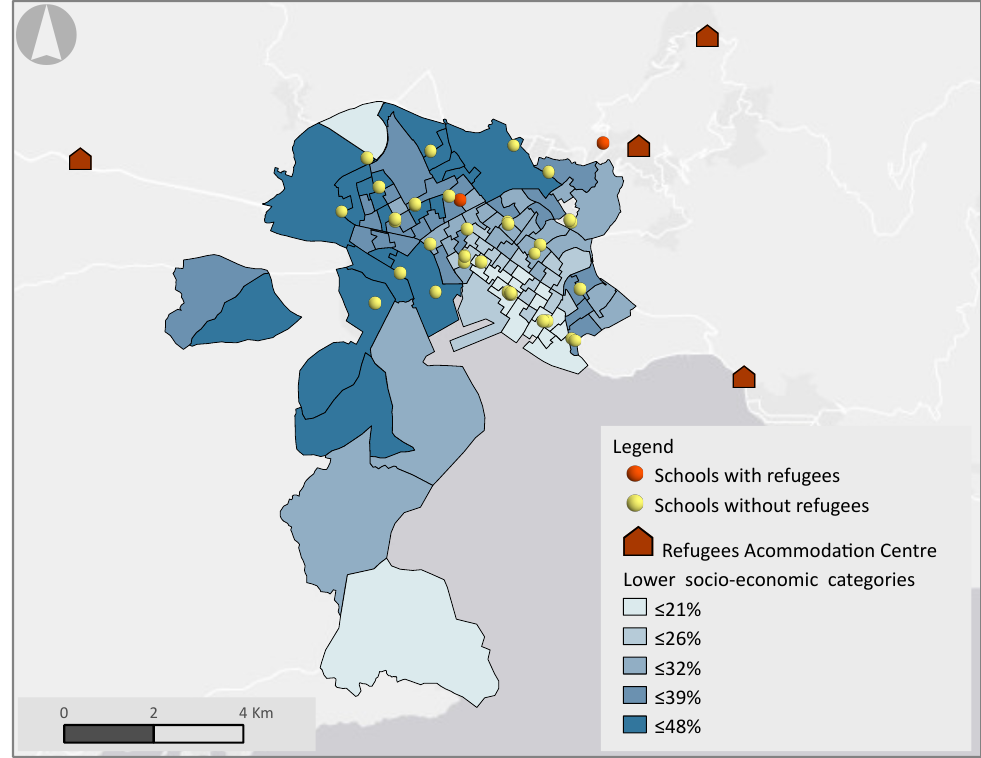
Figure 4. Distribution of lower socio-economic categories (2011) and refugee school population in Volos. Source: Authors’ elaboration and EKKE–ELSTAT